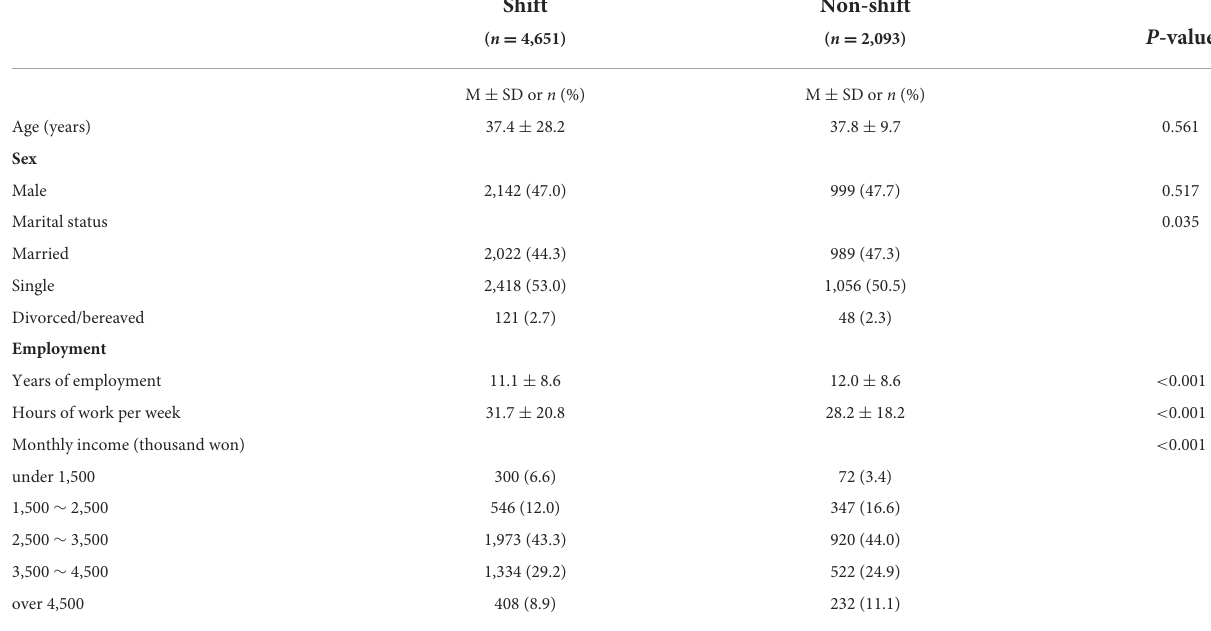
TABLE 1 Demographic characteristics of the study participants ( N = 6,654).